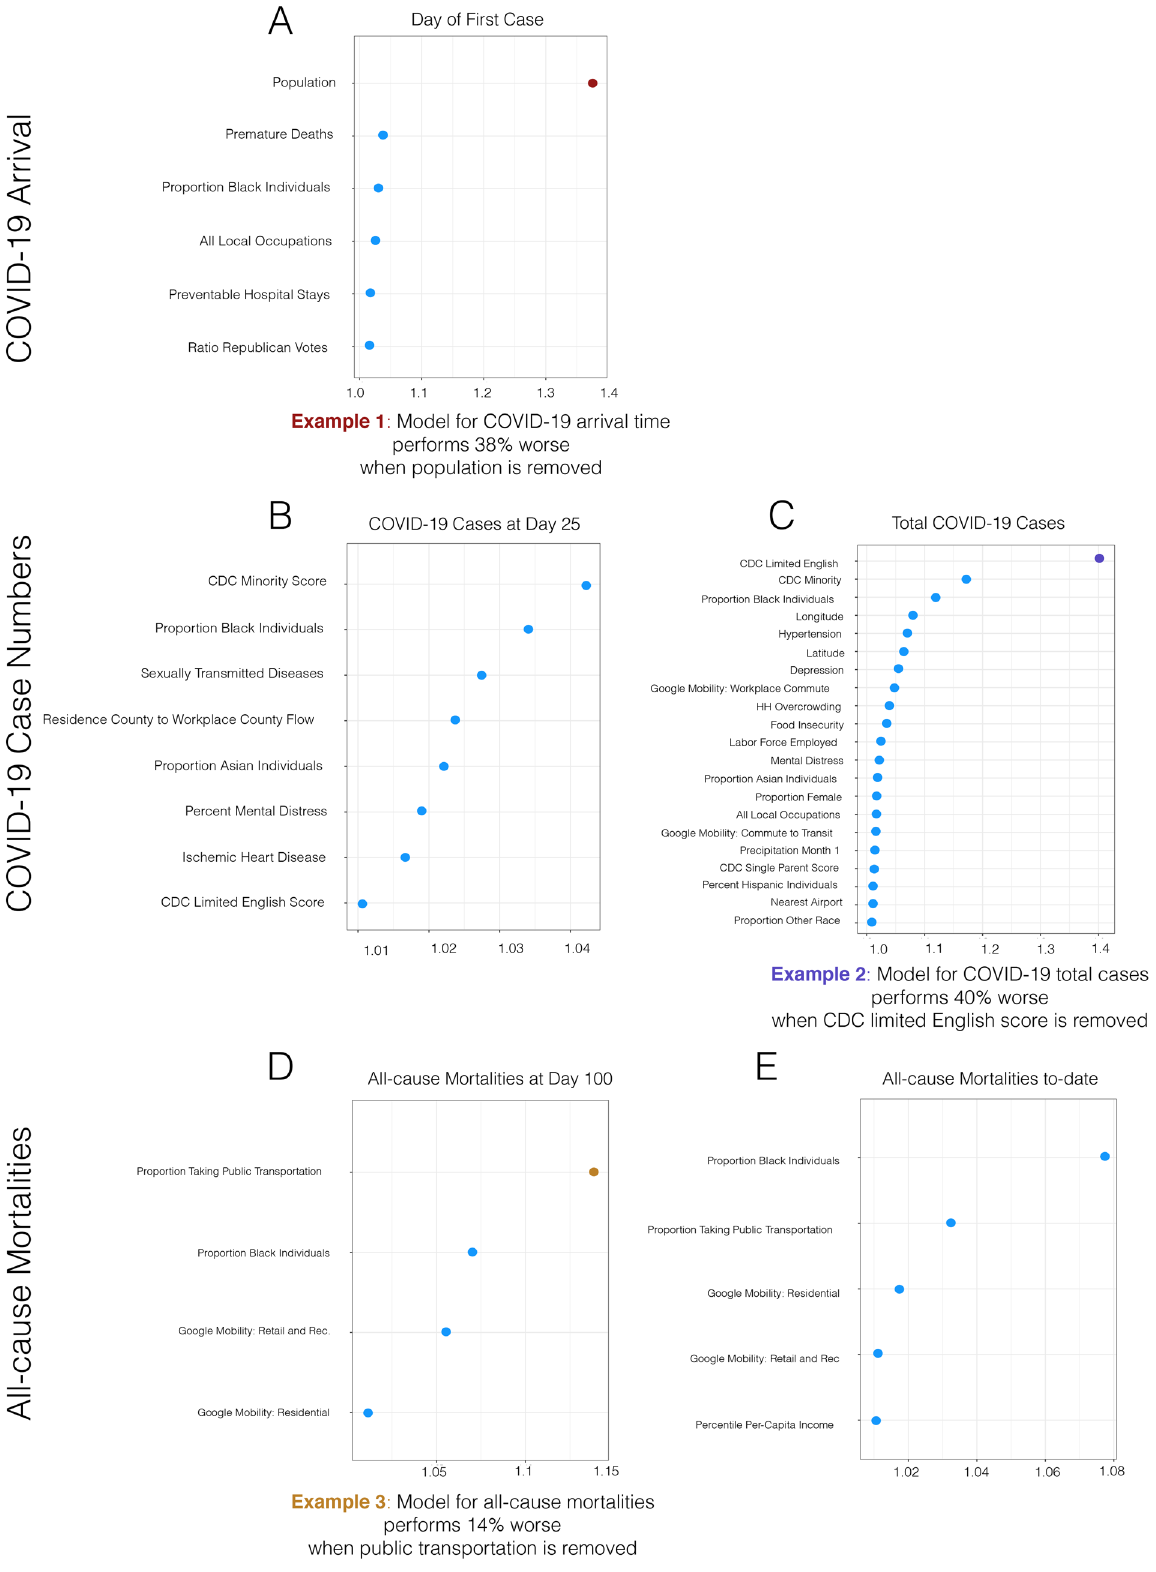
Figure 3. Variable importance as indicated by the relative increase of mean-squared error when a single variable is